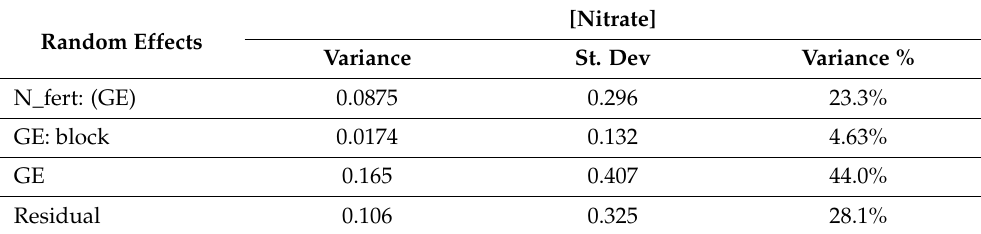
Table 6. Random effects variance, variance standard deviation, and percentage of total variance for the mixed linear model estimating nitrate content ([Nitrate]) in spinach leaves. N_fert: N fertilization treatments; GE: genotype × environment.